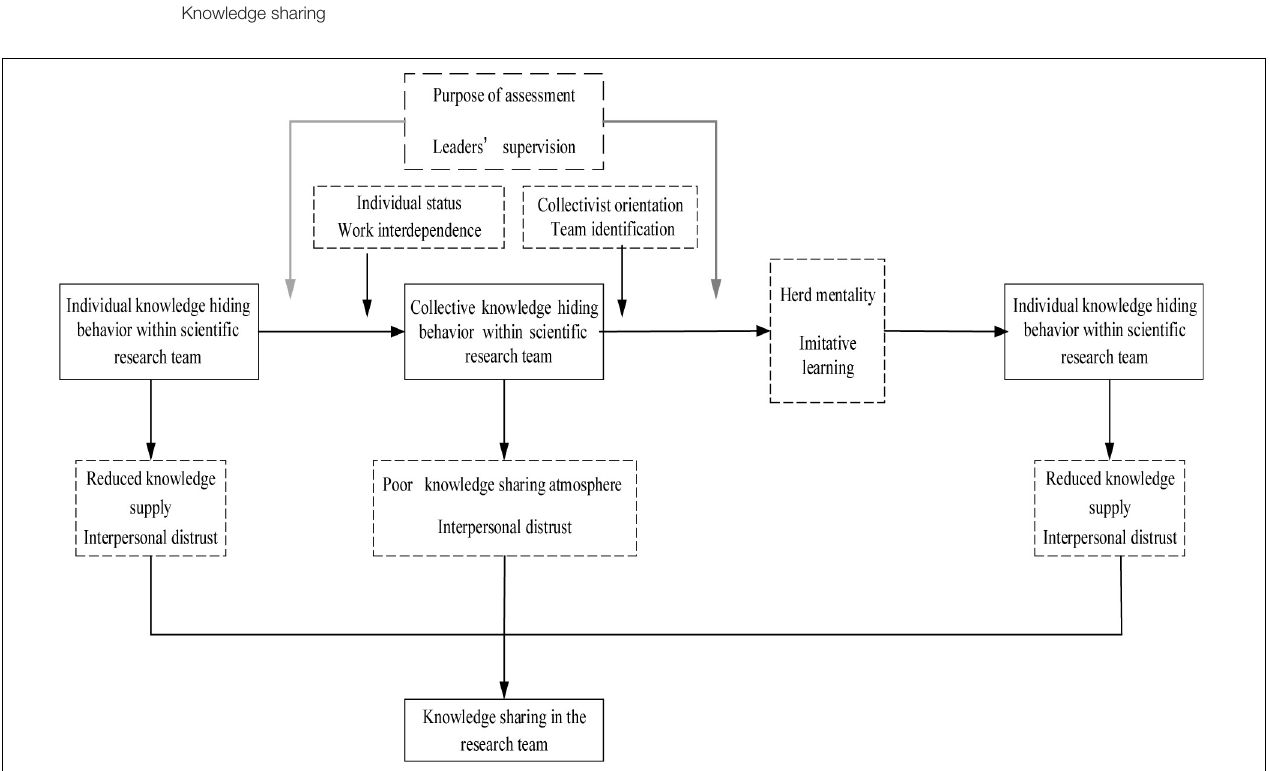
FIGURE 1 | Theoretical model of a scientific research team’s knowledge hiding behavior interaction and its impact on knowledge sharing.